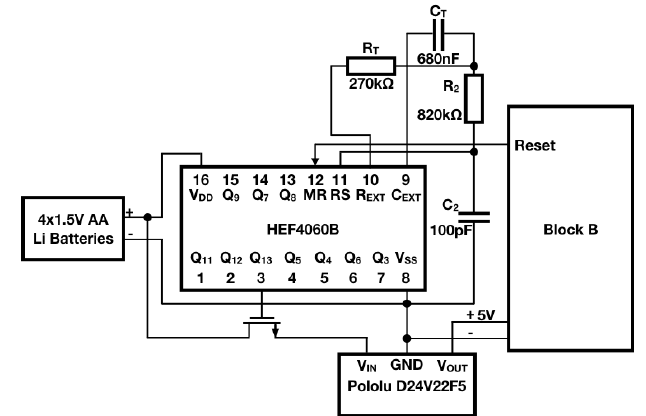
Figure 4. Block diagram of Block A part of the IoT sensor